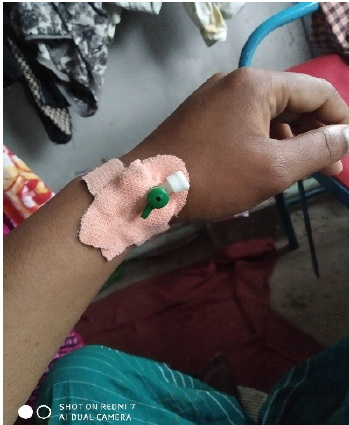
Figure 14. Alt-text: An arm with a cannula bandage in a hospital.